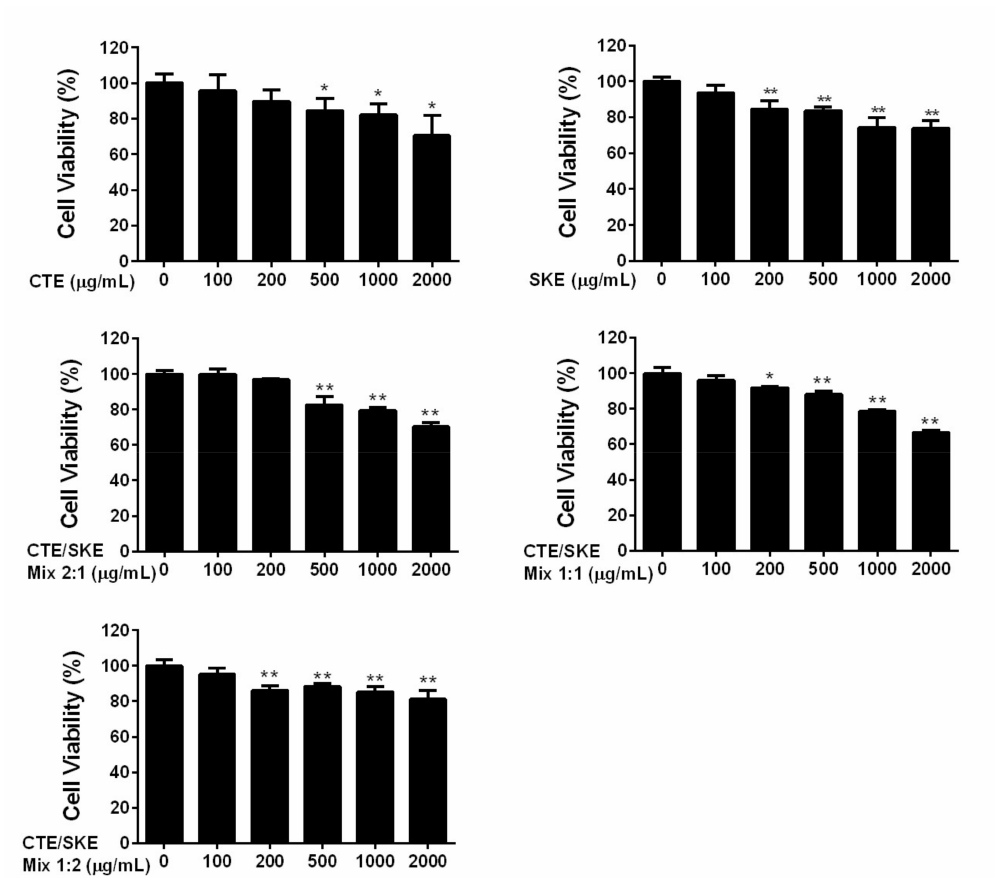
Figure 1. Cytotoxic effect of CTE and CTE mix in RAW264.7 cells. Cell-viability analysis results of CTE only; SKE only; and these two extracts mixed at ratios of 1:1, 1:2, and 2:1. The cells were treated with different concentrations (0, 100, 200, 500, 1000, and 2000 µ g/mL) of a mixture of CTE and SKE in various ratios. After incubation for 24 h, an ELISA reader at an absorbance of 450 nm. (Control vs. * p < 0.05, ** p <